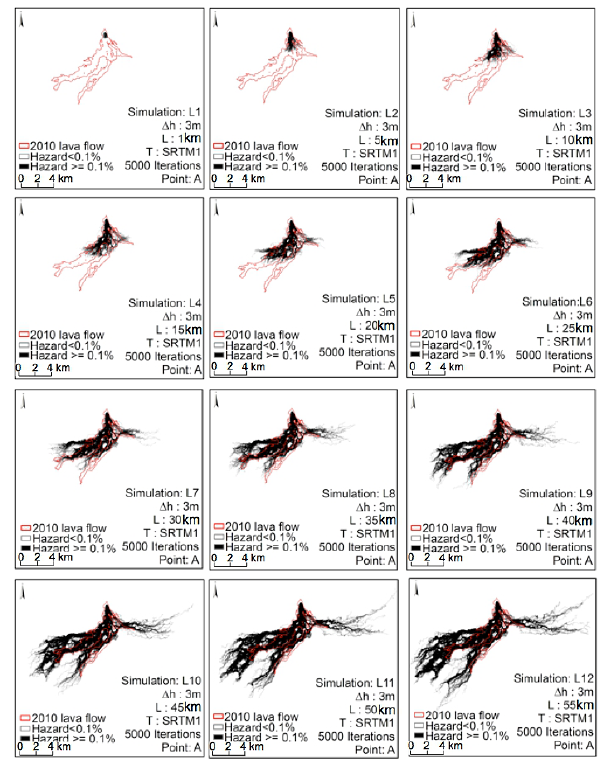
ASTER GDEM data are published with a spatial resolution